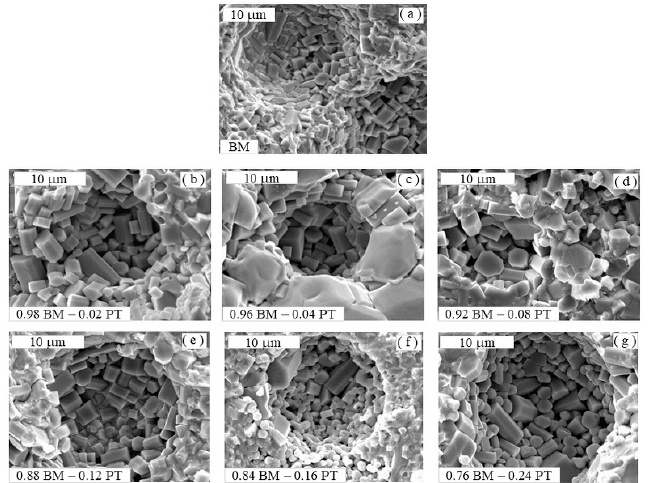
Figure 5. Secondary electron images obtained for the composite ceramics: BM ( a ), 0.98 BM–0.02 PT ( b ), 0.96 BM–0.04 PT ( c ), 0.92 BM–0.08 PT ( d ), 0.88 BM–0.12 PT ( e ), 0.84 BM–0.16 PT ( f ), and 0.76 BM–0.24 PT ( g ).